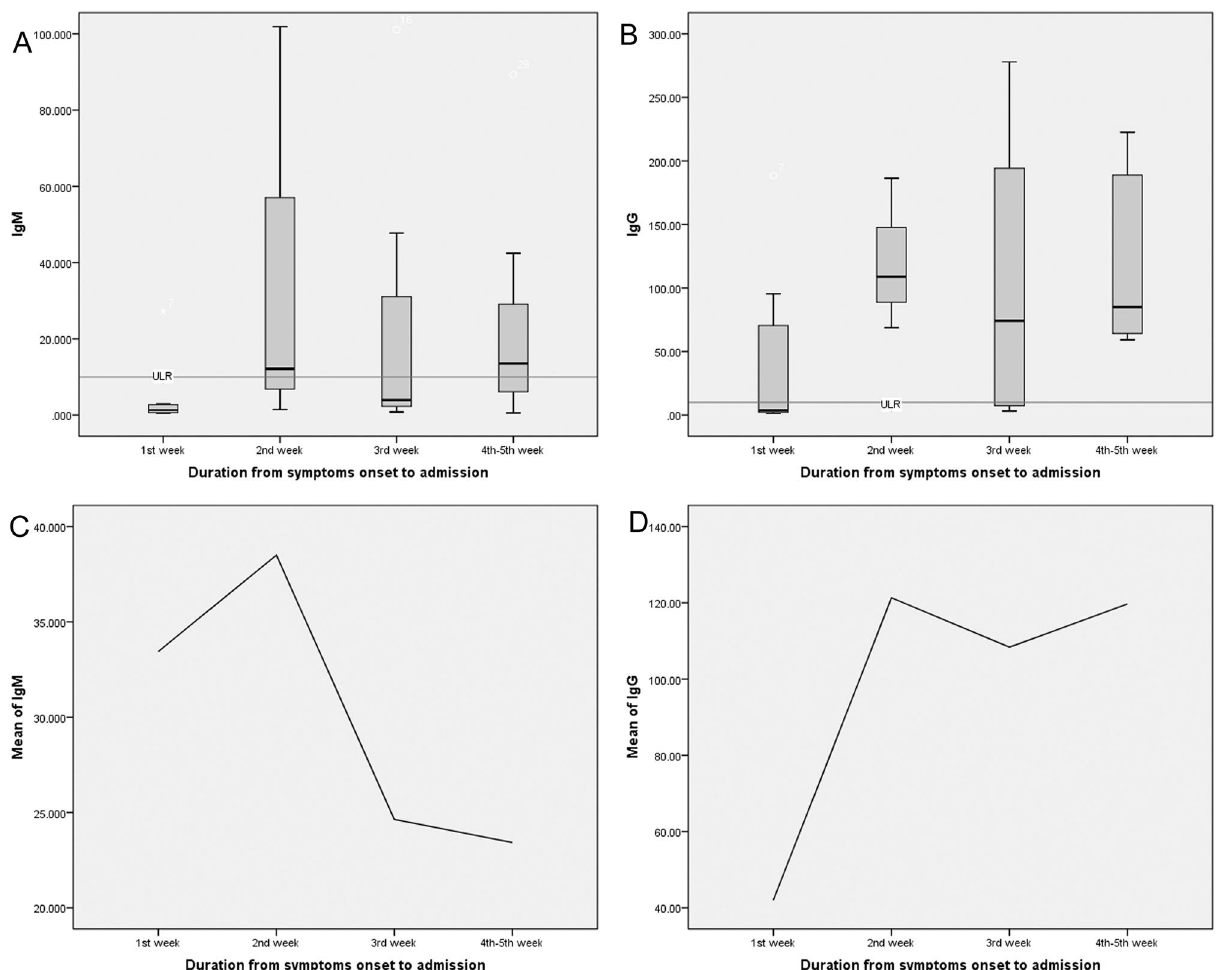
Figure 3. Dynamic profiles of the SARS-Cov-2 antibodies over time in non-severe patients with COVID-19. The tendency of the dynamic changes of the SARS-Cov-2 antibodies was typical. Patients showed remarkably elevated levels of IgM and IgG since the second week after symptoms onset compared with patients who were in the first week after symptoms onset. After that, the relatively high level of IgG was still persistent after 2 weeks, whereas the level of IgM tended to decrease slightly. ULR Upper limit of reference